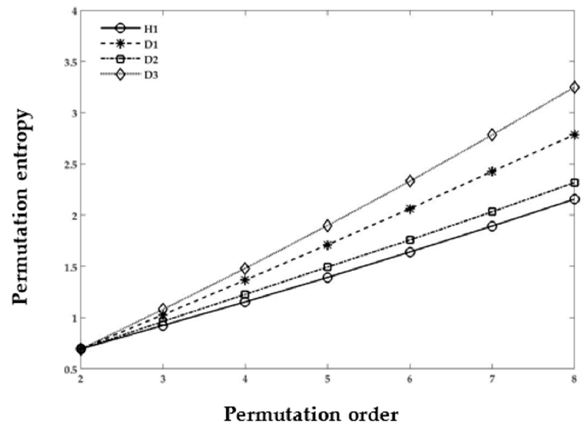
Figure 8. Product Function of Case 1, damage size: 0.007, 0.014, and 0.021 inches; damage type: outer-race; data points: 1024; PE calculation with different m permutation order.